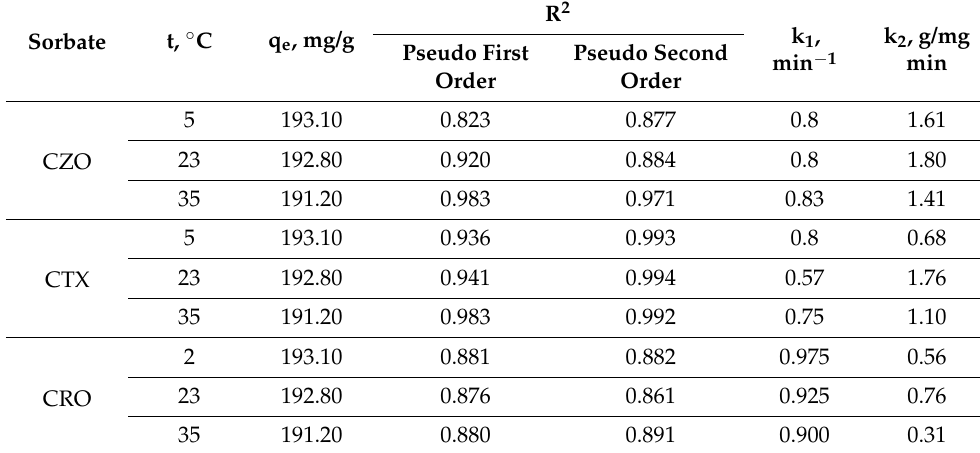
Table 3. Kinetic parameters of the adsorption process.